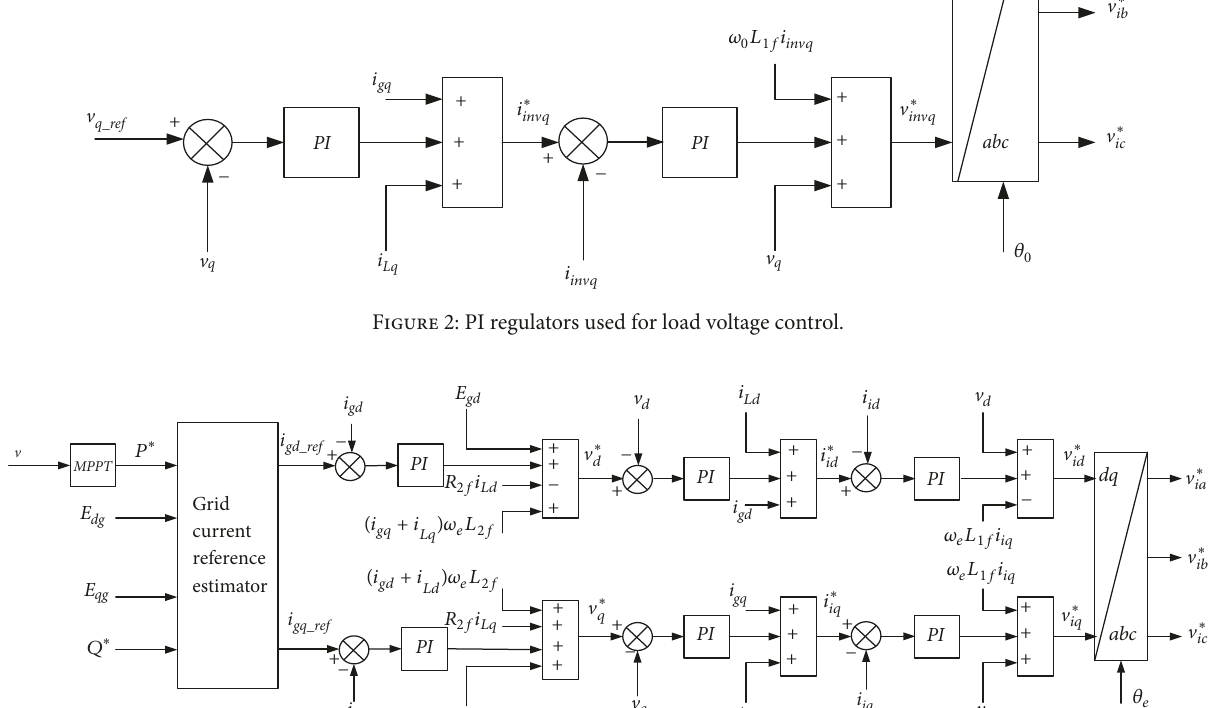
Figure 3: Structure of the PI regulators used for the control of the grid